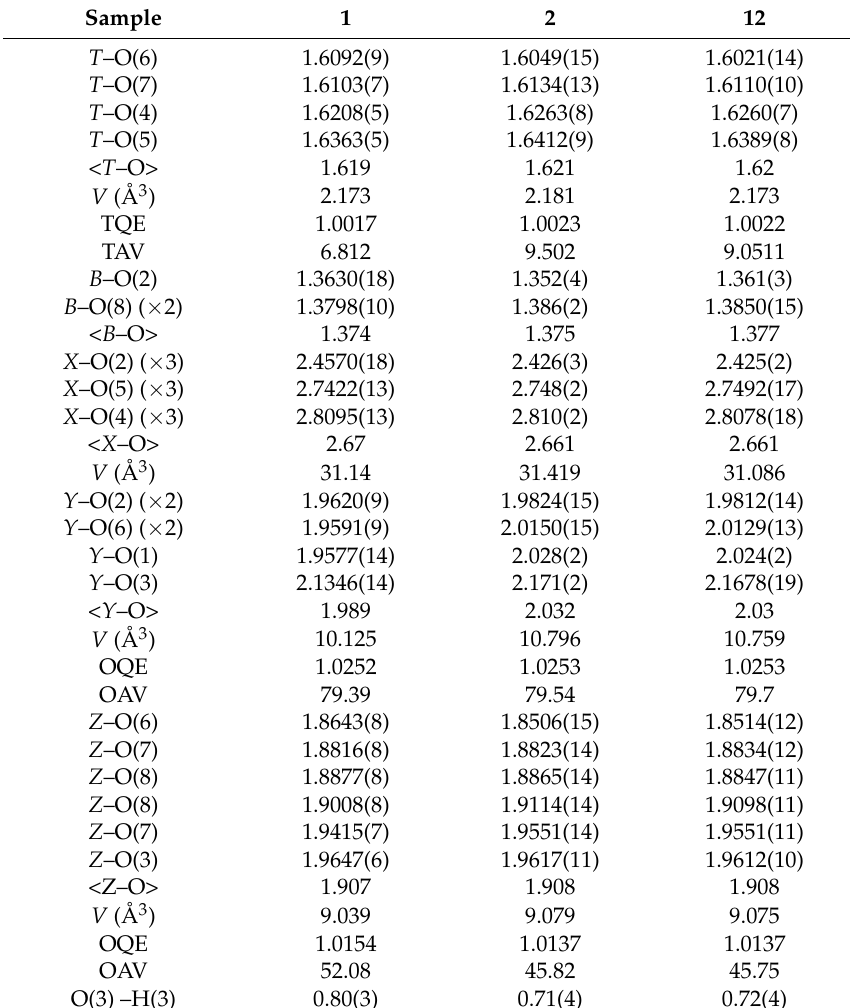
Table 5. Bond lengths [Å] and angles [ ◦ ] for tourmalines 1, 2, 12.